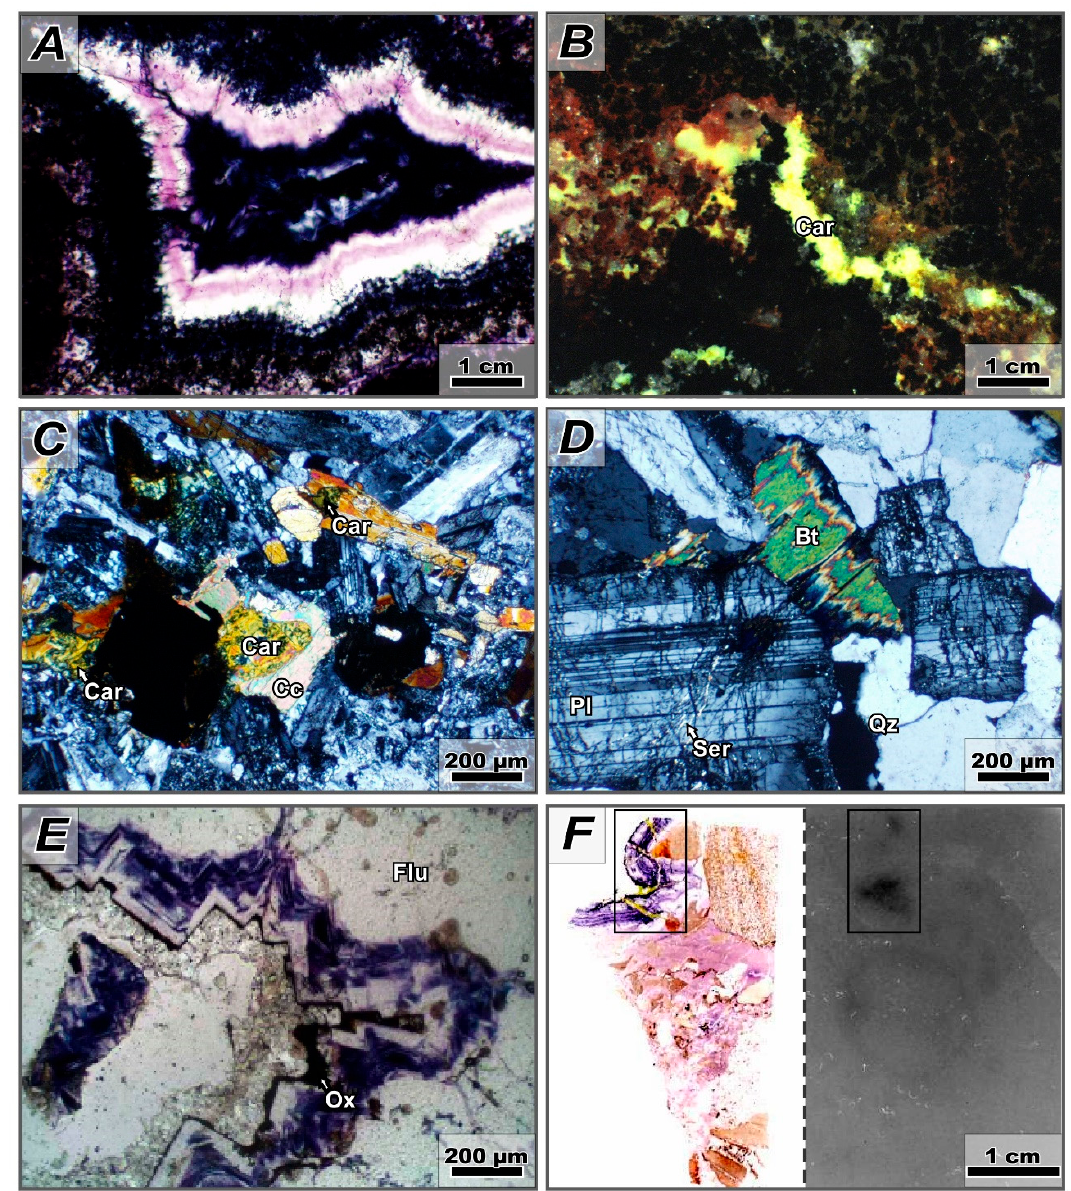
Figure 5. Photomicrographies of thin sections from the U-rich fluorite deposits in the Aguachile area, Coahuila. All images with parallel polars unless otherwise noted. ( A ) Colloform banding as vug lining in late fluorite in MVT-like mineralisation. ( B ) Late stringers with carnotite (yellow) and iron oxihydroxides (reddish). ( C ) Carnotite and calcite replacing magmatic minerals in an Oligocene hypabyssal rhyodacite near the Las Alicias area. ( D ) Incipient sericitic alteration in a granitic porphyry near the Las Alicias area. ( E ) Purplish to colourless euhedral lining of fractures as overgrowths on MVT-like fluorite (colourless) followed by iron oxihydroxides and V-Mo-P mineralisation with little U. ( F ) Thin section of a MVT-like fluorite breccia crossed by a late fluorite-U-V-Mo-P stringer (encased within a rectangle) with its self-radiography on the right-hand side; notice the change in colour of fluorite from the MVT-like associations (light purple to pink) to the late hydrothermal stringers (deep purple), which include yellow carnotite. Key: Bt = biotite, Car = carnotite, Cc = calcite, Flu = fluorite, Ox = iron oxihydroxides, Pl = plagioclase, Qz = quartz, Ser = “sericite”.